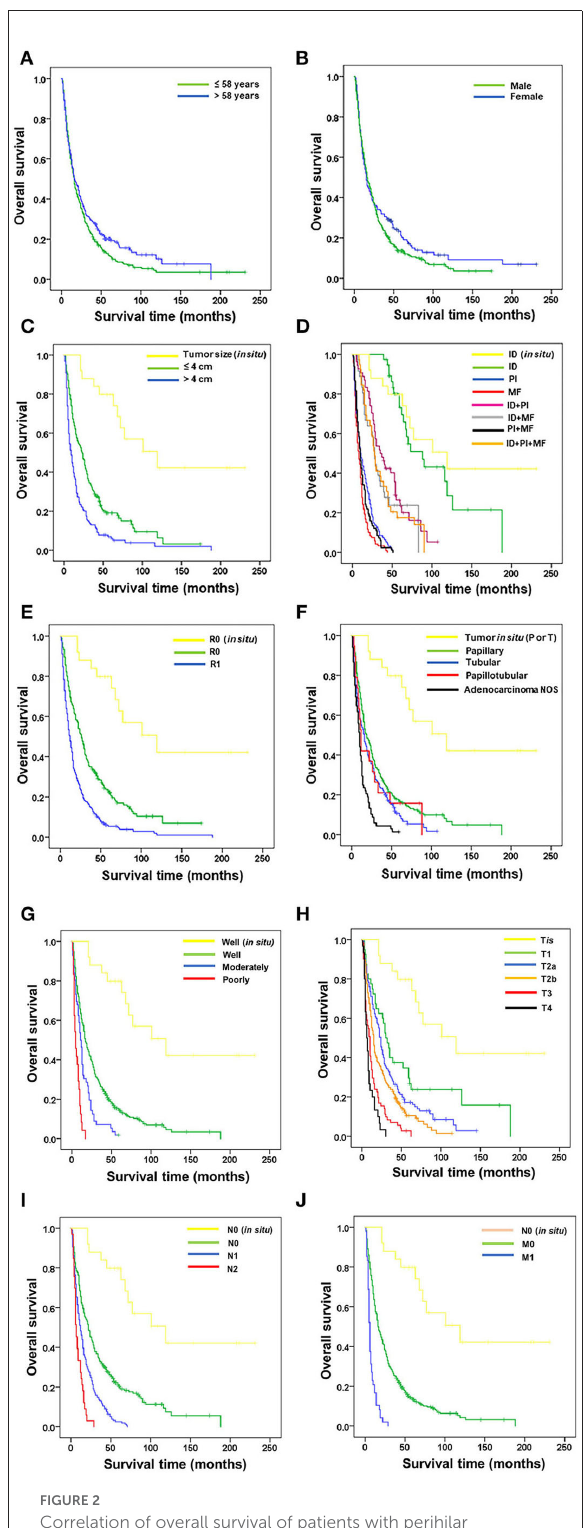
FIGURE2 Correlation of overall survival of patients with perihilar cholangiocarcinoma with clinicopathological features. Correlation of OS with (A) age, (B) gender, (C) tumor size, (D) growth patterns, (E) surgical margin, (F) histological type, (G) histological grade, (H) T stage, (I) lymph node metastasis, and (J) distant